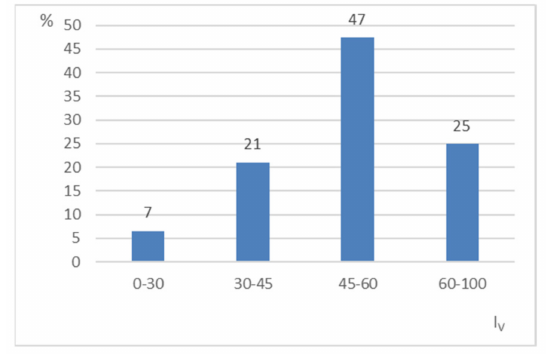
Figure 8. Vulnerability index distribution in the historical